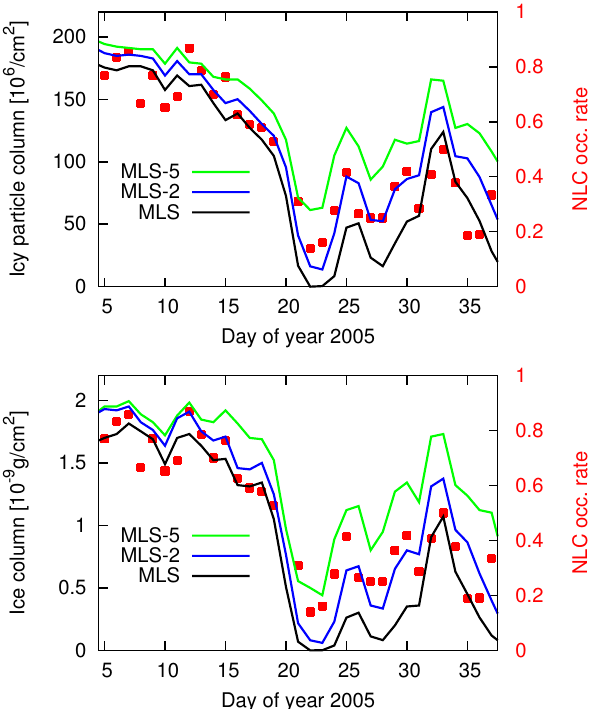
Fig. 6. Upper panel: total column of icy particles in units of 10 6 cm − 2 for three model simulations at 75 ◦ S with different tem- peratures: (black line) MLS temperature field, (blue line) MLS tem- peratures minus 2K, and (green line) MLS temperature minus 5K as well as (red dots) NLC occurrence rate from SCIAMACHY mea- surements. Lower panel: as the upper panel, but total ice column in units of 10 − 9 gcm − 2 . The particles in the smallest radius bin are excluded. The model results are averages for the time period of the SCIAMACHY measurements (Sect. 5).